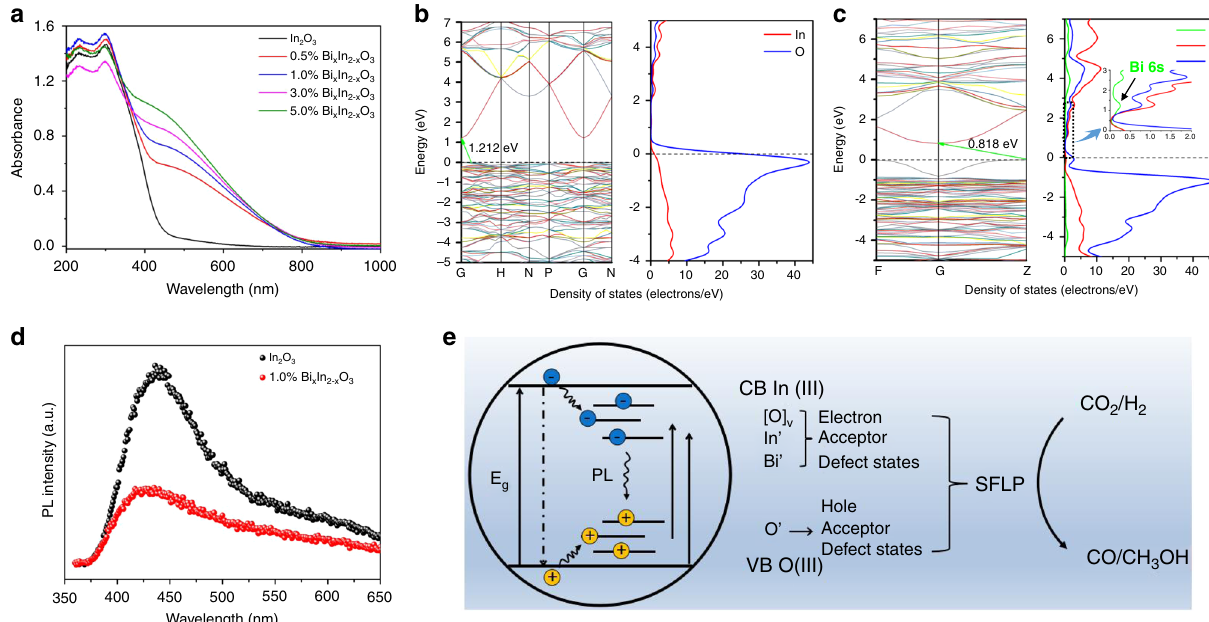
Fig. 4 Electronic structures of Bi x In 2 – x O 3 . a Diffuse re fl ectance spectra of pristine In 2 O 3 and various Bi x In 2 – x O 3 nanocrystals. b The simulated band structure and DOS plots of pristine In 2 O 3 . c The simulated band structure and DOS plots of Bi x In 2 – x O 3 nanocrystals. d Room-temperature PL spectra of pristine In 2 O 3 and 1.0% Bi x In 2 – x O 3 nanocrystals using an excitation wavelength of 325 nm. e Schematic illustrating charge carrier recombination pathways on surface defects states (SFLPs) and enabling CO 2 hydrogenation